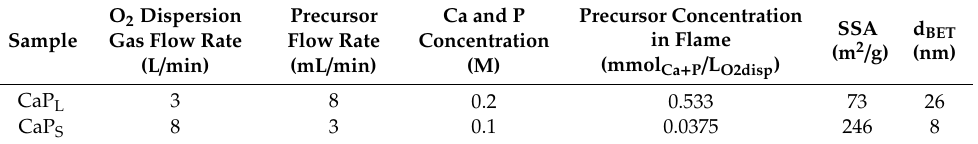
Table 1. Flame spray pyrolysis (FSP) processing conditions (O 2 dispersion gas flow rate, precursor flow rate and concentration) and calculated precursor concentration used for the synthesis of the calcium phosphate (CaP) nanoparticles, along with their specific surface area (SSA) measured by N 2 adsorption and the corresponded primary particle diameter (d BET